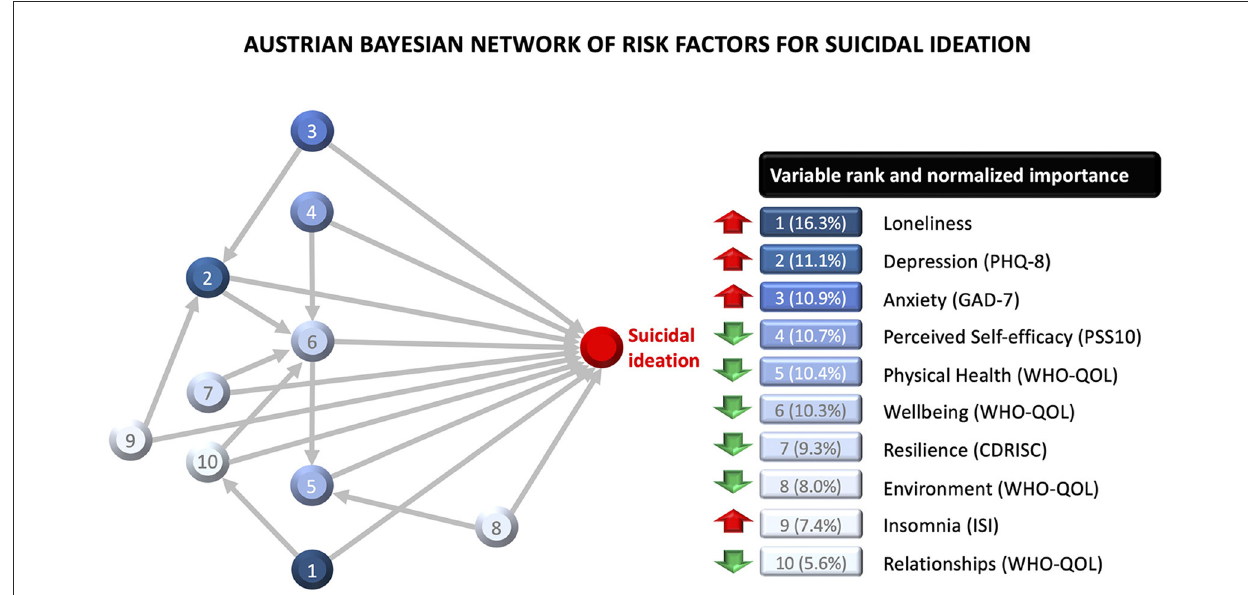
FIGURE2 Bayesian network model for the Austrian sample, with variable importance indices for each variable. The red upward arrows denote risk factors for suicidal ideation, and the green downward arrows denote protective factors. The model also shows two-way interactions between variables.